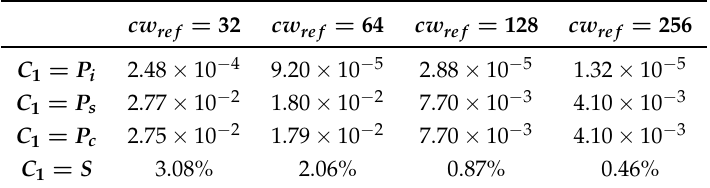
Figure 1. The logarithmic variance of ∂ P I ( cw , θ ) / ∂ cw , ∂ P S ( cw , θ ) / ∂ cw and ∂ S ( cw , θ ) / ∂ cw , when cw changes from 32 to 700 and θ changes from 0 to 1. N ( cw ) Table 1. The certification results of in the cases where channel contention level is indicated by | | different channel